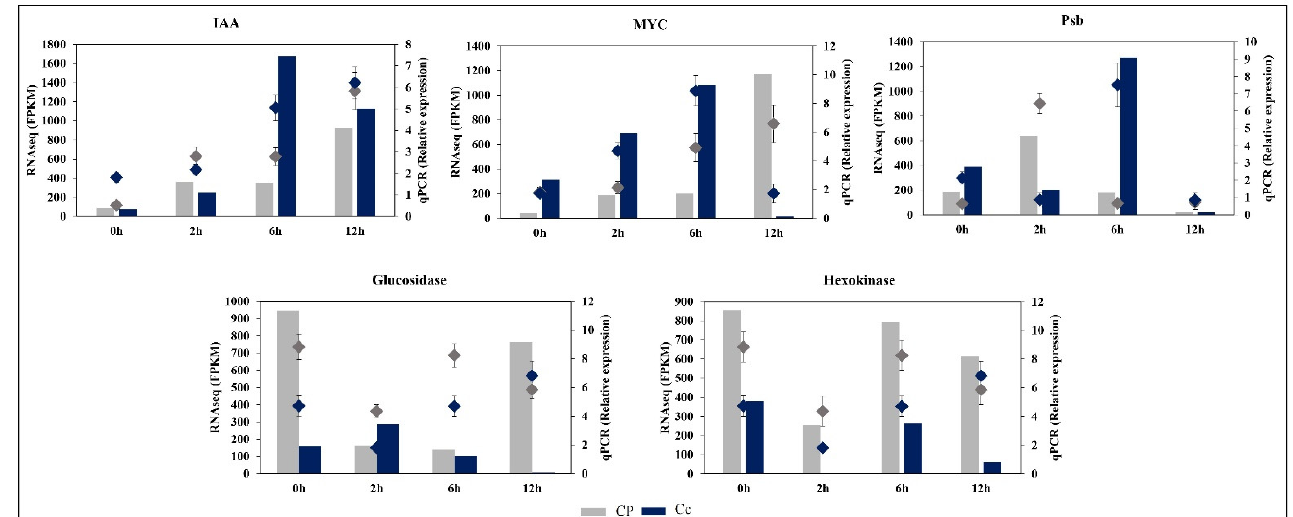
Figure 11. The expression profiles of significantly differentially expressed genes were measured by RNA-seq and qRT PCR. The histogram data represent the RNA-seq data (left Y-axis) and the marker represents the qRT-PCR data (right